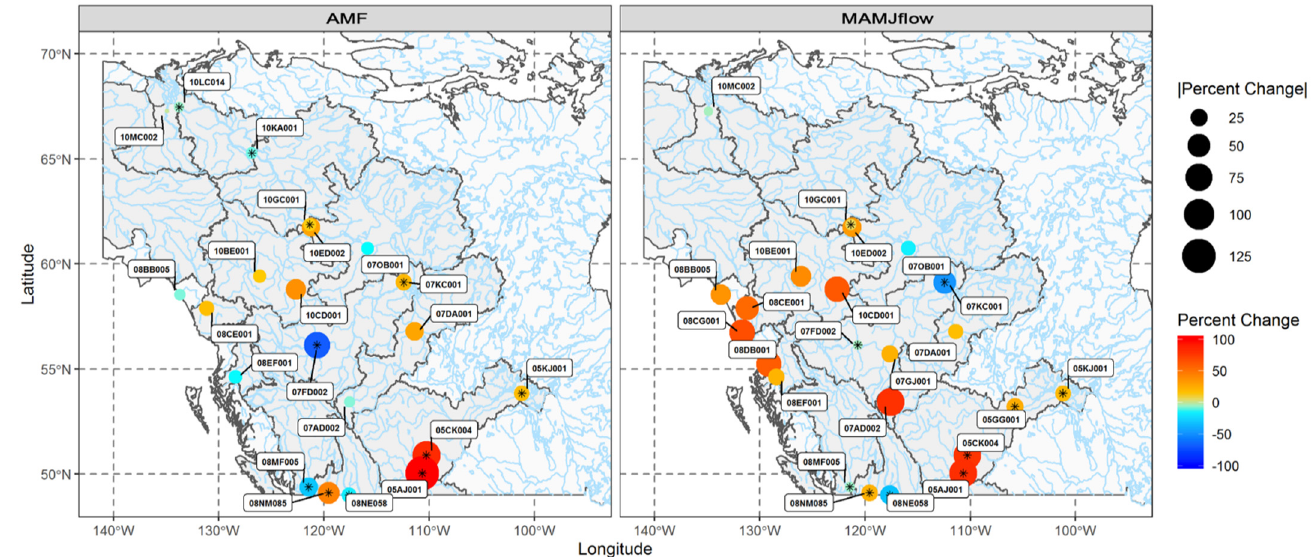
Figure 8. Spatial distribution of projected changes in annual maximum flow (AMF) and mean spring flow (MAMJflow) corresponding to the RCP8.5 and the far future (2071–2100) period (predictions made with SWEmax; asterisks indicate regulated stations).